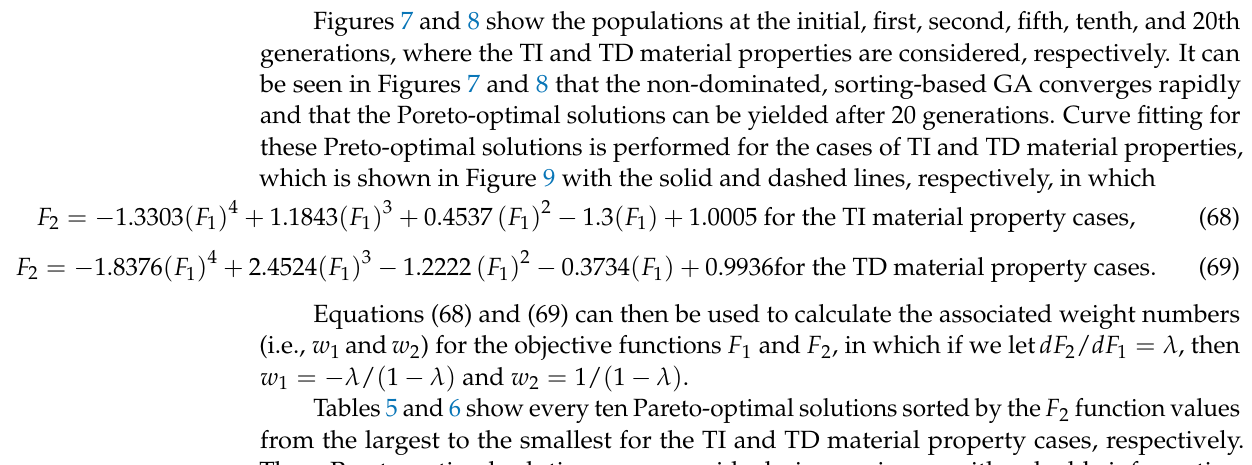
Figure 6. Variations of material properties of the ceramic and the metal materials with the temperature: ( a ) Young’s modulus; ( b ) Poisson’s ratio; ( c ) Thermal expansion